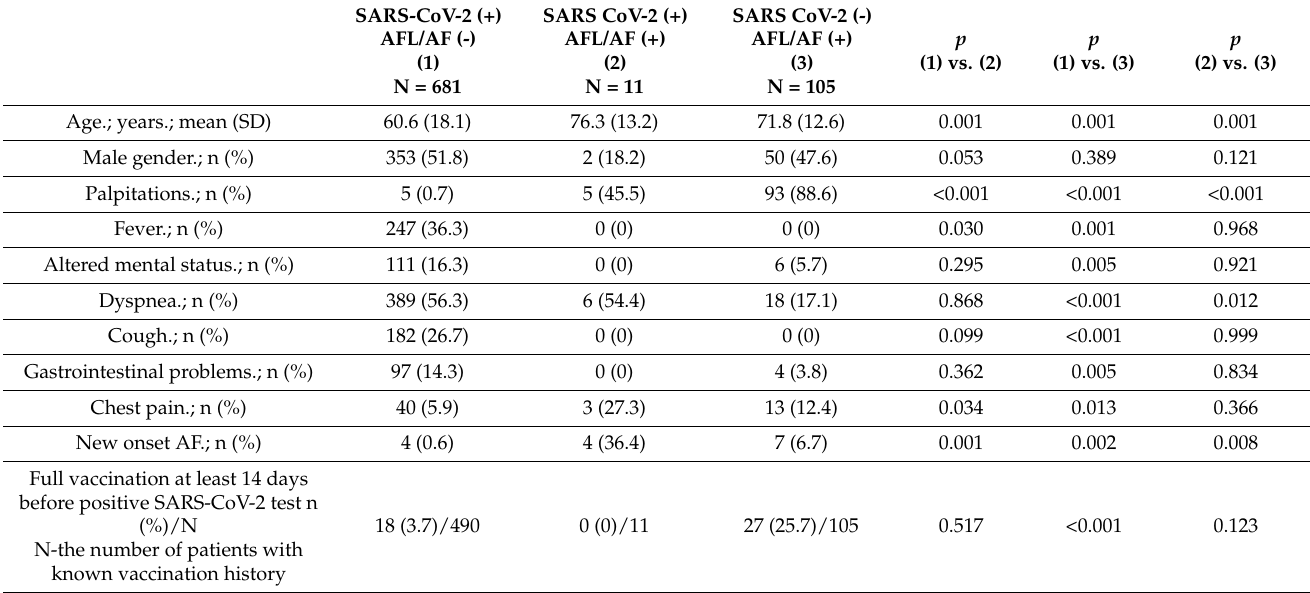
Table 2. Main complaints at the time of admission to the